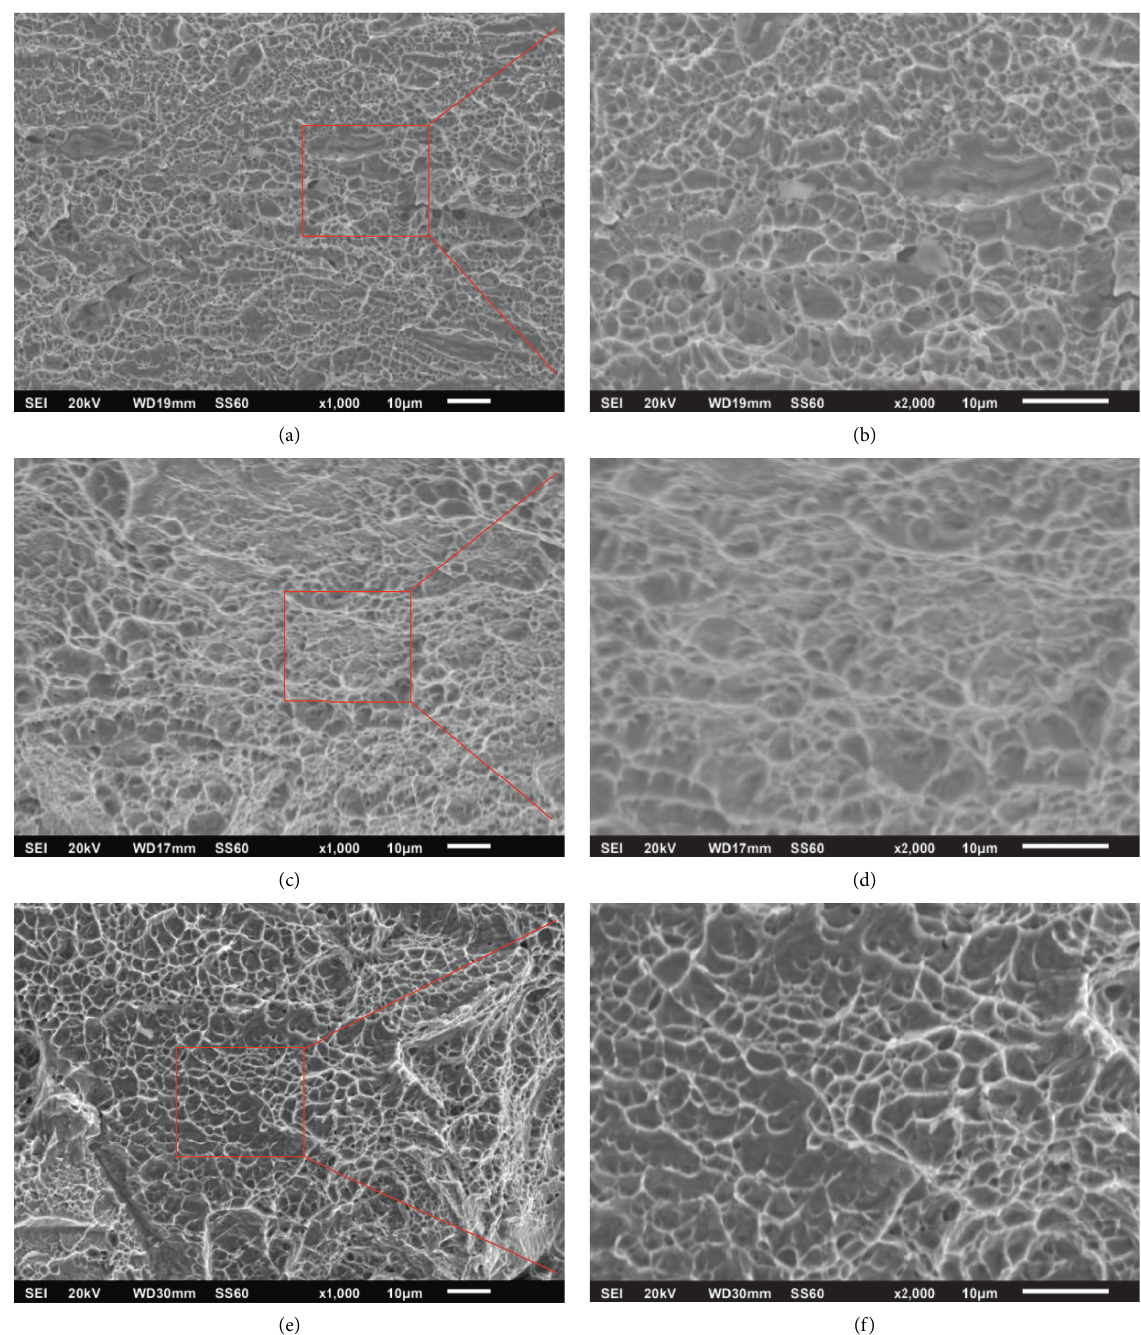
Figure 10: Tensile fracture morphology in the crack healing area at different values of FR. (a, b) FR of 1.8. (c, d) FR of 2.0. (e, f) FR of